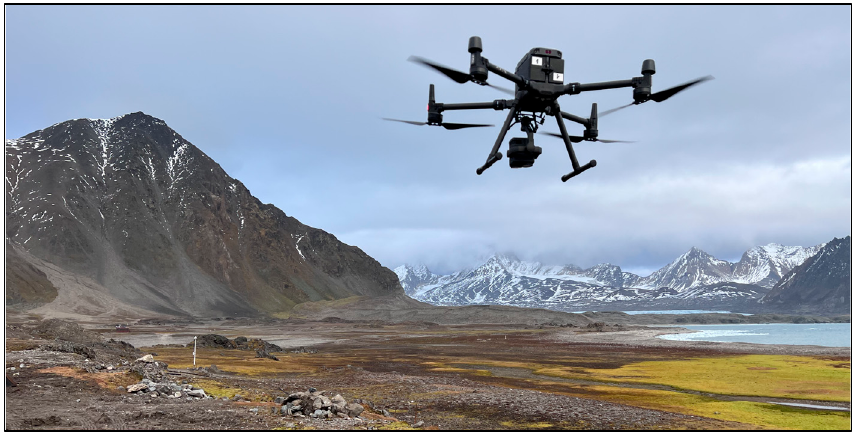
Figure 2. DJI Matrice 300 RTK Drone equipped with Zenmuse P1 camera during the mission at Fuglebekken catchment.